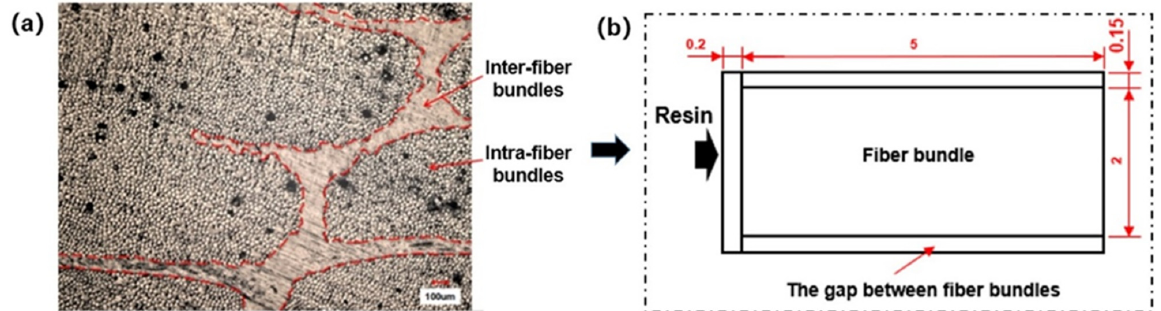
Figure 3. ( a ) Cross section morphology of the fiber reinforced composites under optical microscope. ( b ) The corresponding physical model of fiber reinforcement dual-scale structure established with geometrical unit of mm.